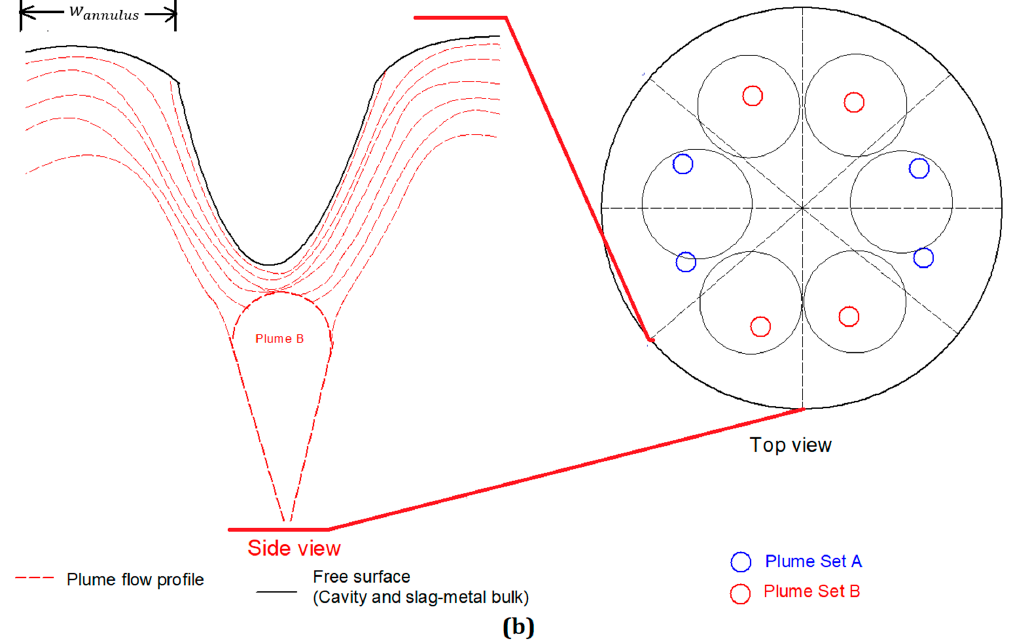
Figure 2. Schematic representation of the interaction between cavities and plumes ( a ) Expansion of plume set A underneath cavities (Side view), ( b ) Expansion of plume set B underneath cavities (Side view).